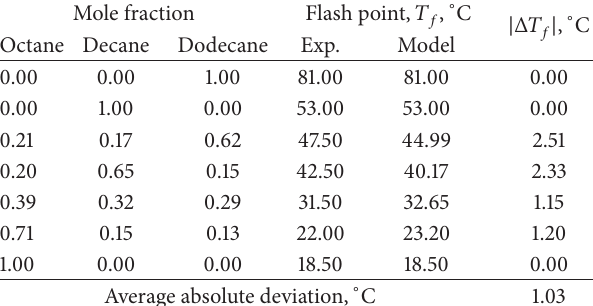
Table 8: Flash point of octane + decane + dodecane with different mole